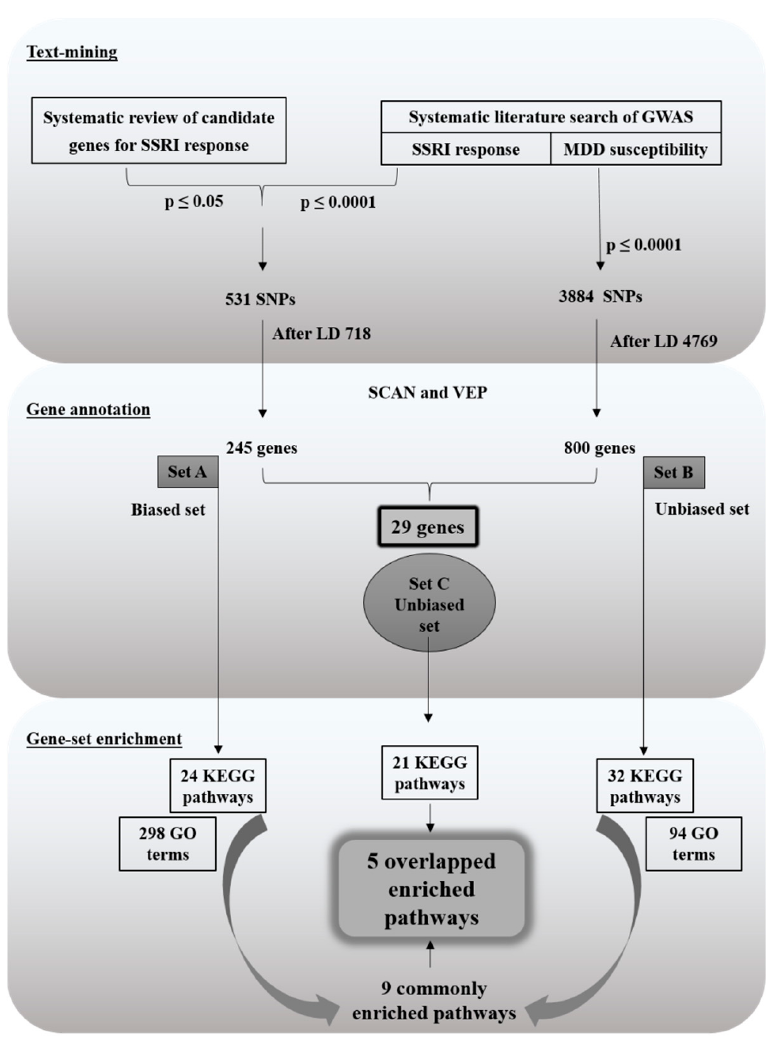
Figure 4. Flow chart of the study.